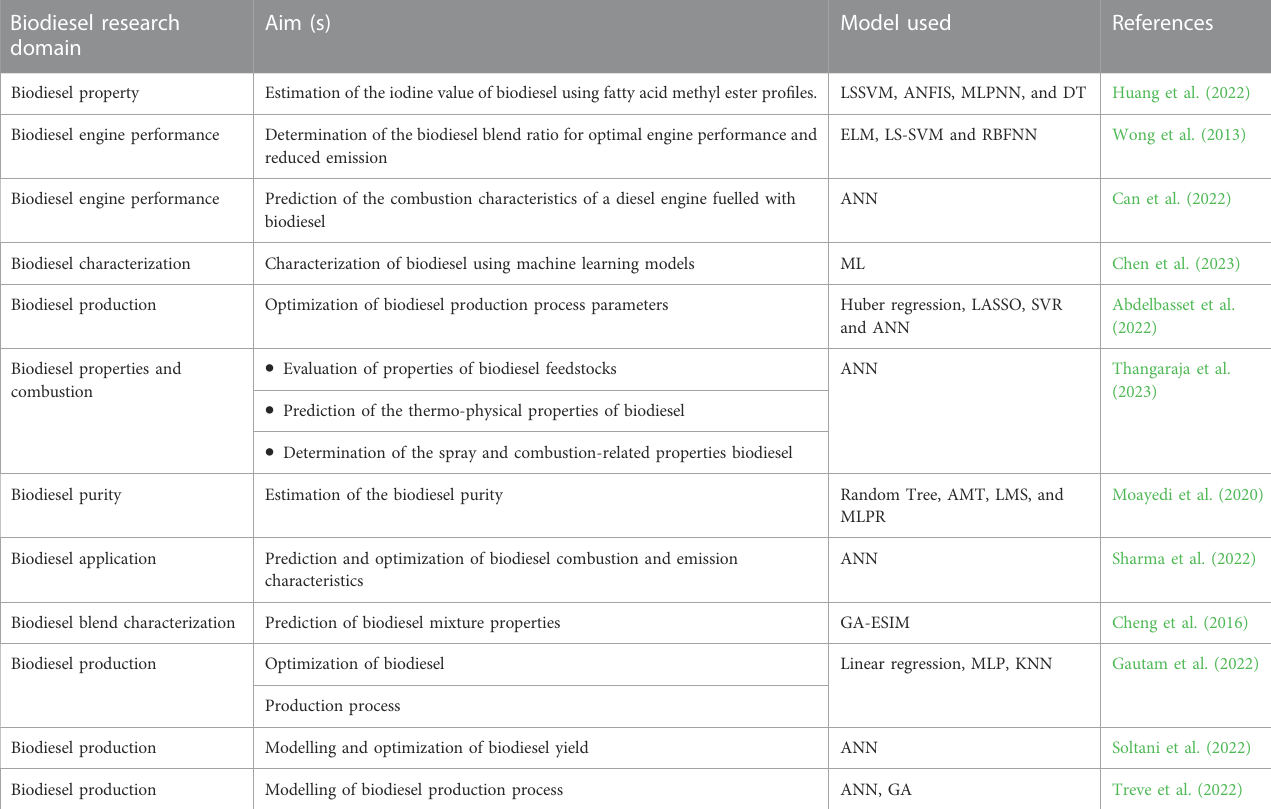
TABLE 4 Recent publication on the application of ML technologies in biodiesel